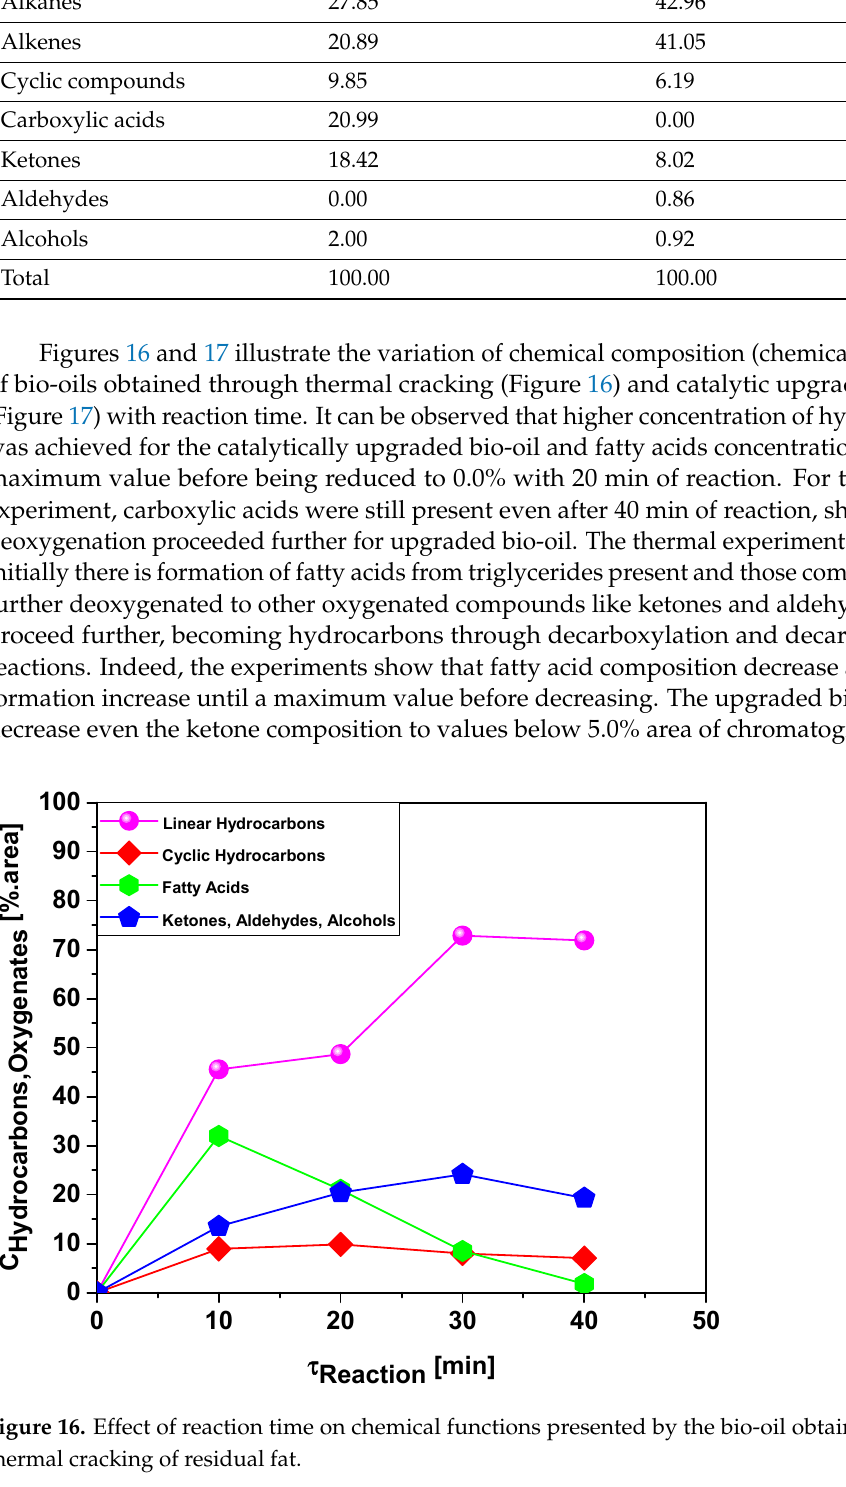
Figure 17. Effect of reaction time on chemical functions presented by the bio-oil obtained through the upgrading process. Figures 18 and 19 illustrate the effect of reaction time on the content of hydrocarbons and oxygenates, respectively. The chemical functions, sum of peak areas, CAS numbers,